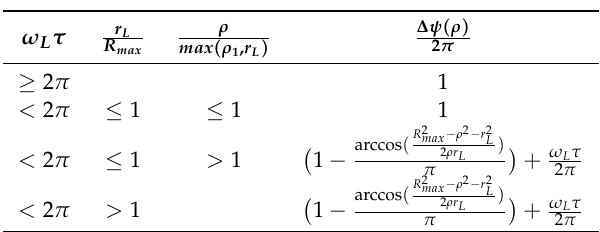
∆ ψ ( ρ ) Table 1. vs. relevant 2 π